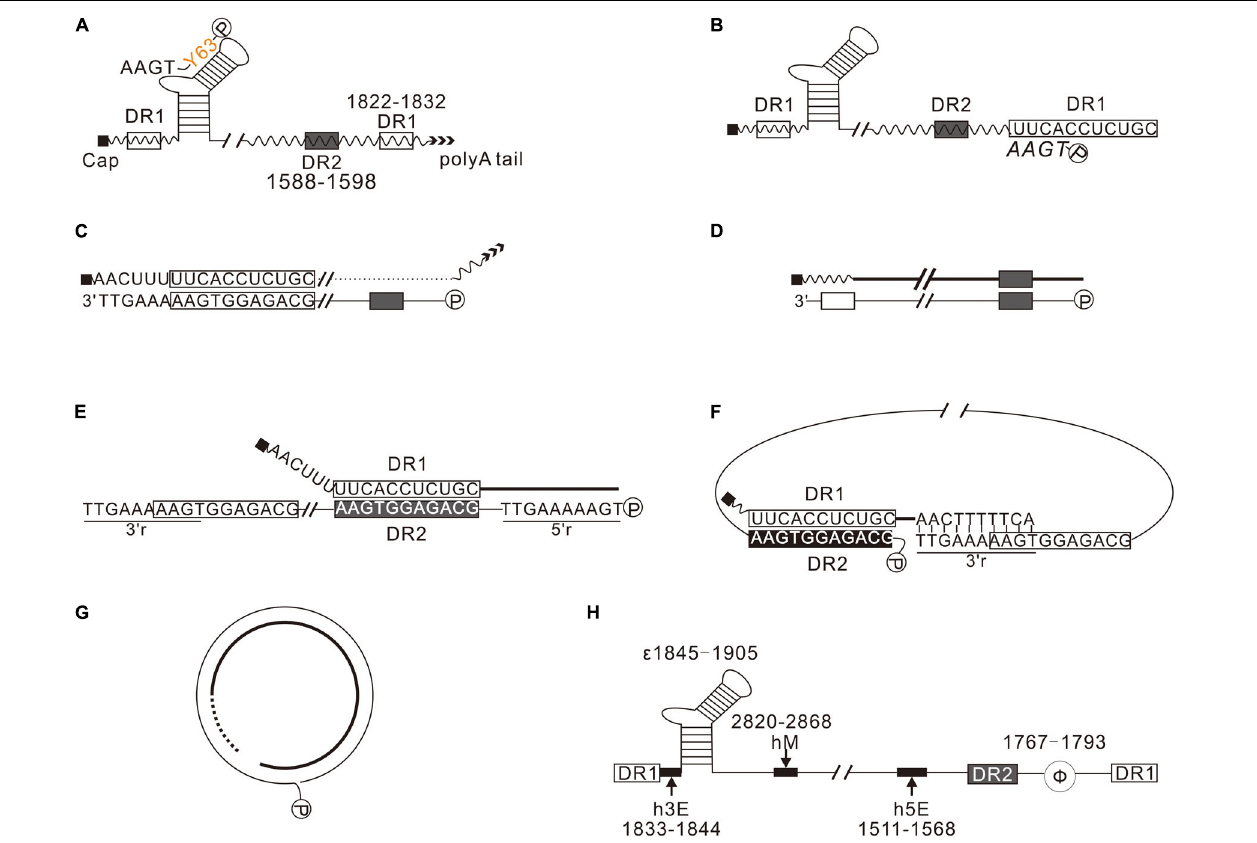
FIGURE 1 | Synthesis of HBV DNA. (A) Pol (P) binds to 5 (cid:48) -proximal epsilon, forming a ribonucleoprotein complex with pgRNA, encapsidated into nucleocapsid formed by HBC. In the nucleocapsid, using the bulge of epsilon as a template, Pol synthesizes the minus-strand primer. (B) The nascent minus-strand primer translocates to 3 (cid:48) -proximal DR1 of pgRNA via base pairing. (C) pgRNA was degraded by the RNase H domain of Pol during reverse transcription, leaving a 11–16 nt long oligonucleotides, which serves as the primer for plus-strand synthesis. (D) A few plus-strand primers are retained in situ and extend to the 5 (cid:48) -end of minus-strand DNA, forming duplex linear DNAs (DL DNAs). (E) Most plus-strand primers translocate to DR2. Here, the synthesis of plus-strand resumes and extends to the 5 (cid:48) -end of minus-strand. (F) The nascent plus-strand pairs with the 3 (cid:48) r of minus-strand to complete circularization. (G) The plus-strand is synthesized further to form RC DNA. (H) cis -Elements play a crucial role in HBV replication. h5E (1511–1568), hM (2820–2868), and h3E (1833–1844) are crucial for plus-strand primer translocation. (cid:56) (1767–1793) is important for minus-strand primer